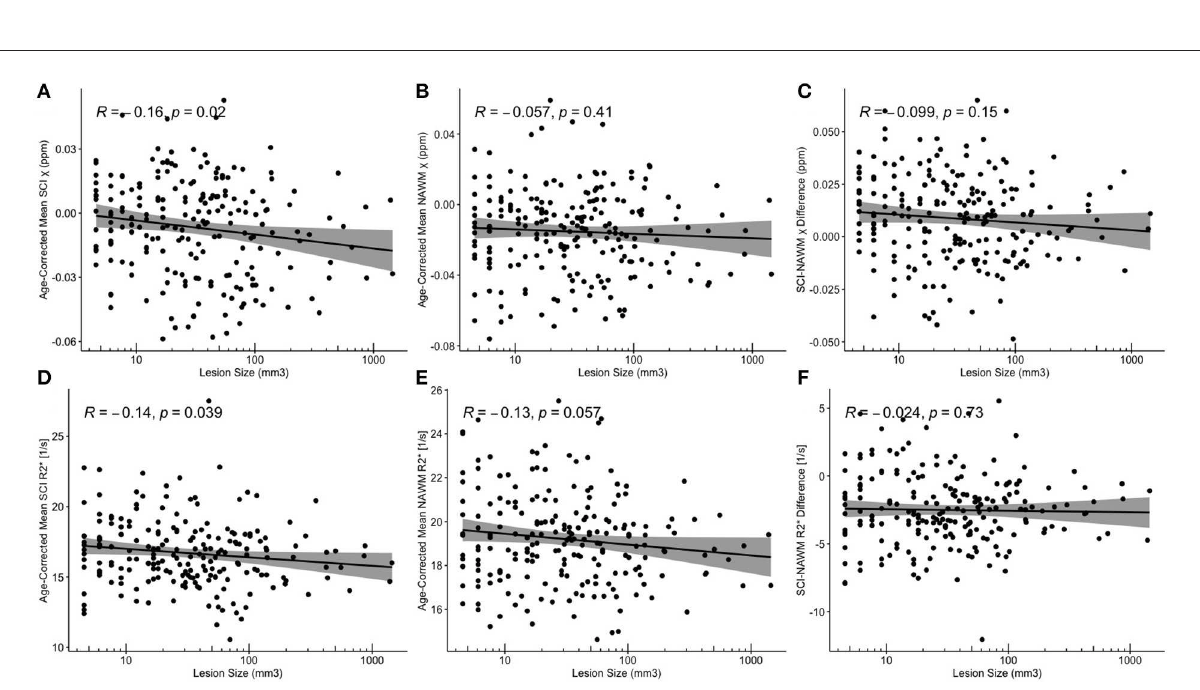
FIGURE8 Correlations between SCI and NAWM χ and R * 2 and lesion volume. (A,D) Mean silent cerebral infarct (SCI) (B,E) normal appearing white matter (NAWM) (C,F) SCI-NAWM differences in susceptibility ( χ ) and R2* as a function of lesion volume plotted on a logarithmic scale. Mean SCI χ and R2* in regions segmented based upon the FLAIR-based